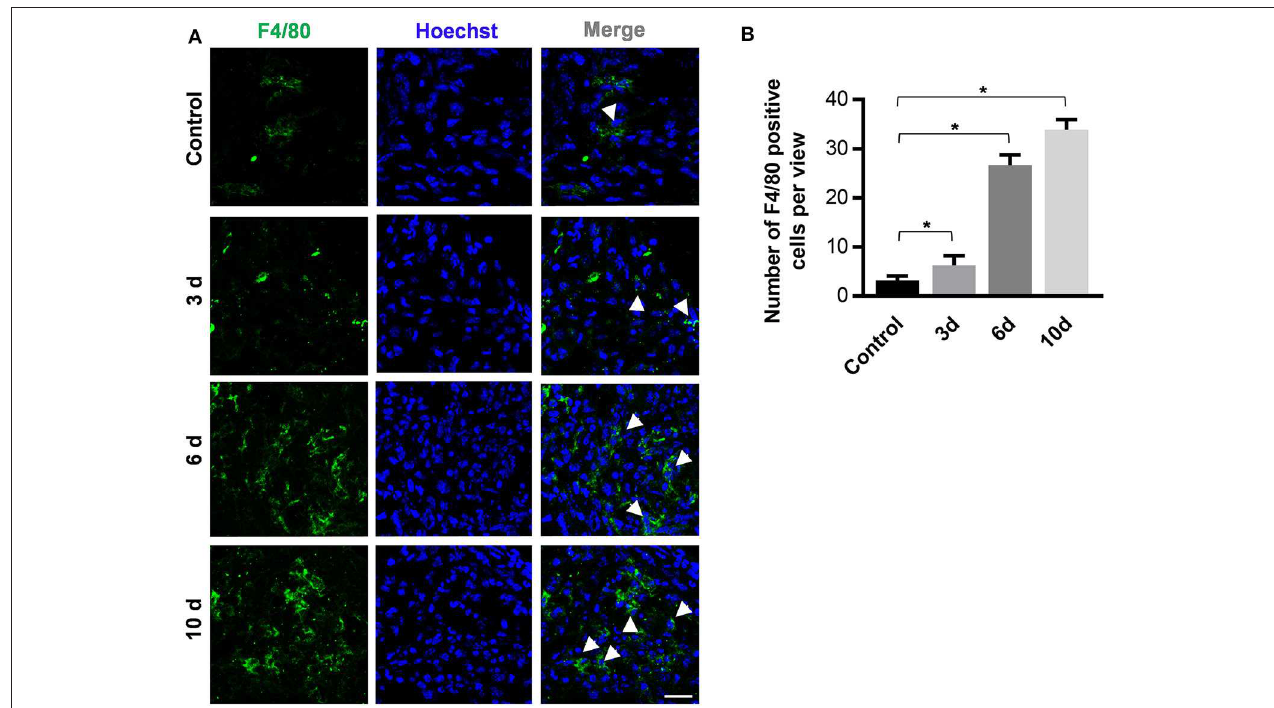
FIGURE 3 | The periodontitis induction method of orthodontic wire insertion aggravates macrophage infiltration in periodontal tissues. (A) Sliced sections of periodontal tissues which were collected at 0, 3, 6, and 10 days after wire-placement. The interproximal space between the first molar and the second molar is observed. Representative confocal images of stained periodontal tissues. Arrowheads mark F4/80 + cells. (scale bar, 25 µ m). (B) The number of F4/80 positive cells in the view of (A) between the first and the second molars were calculated at all time points. Data are shown as mean ± SD. * P < 0.05. ( n = 3, One-way ANOVA, Tukey’s multiple comparisons